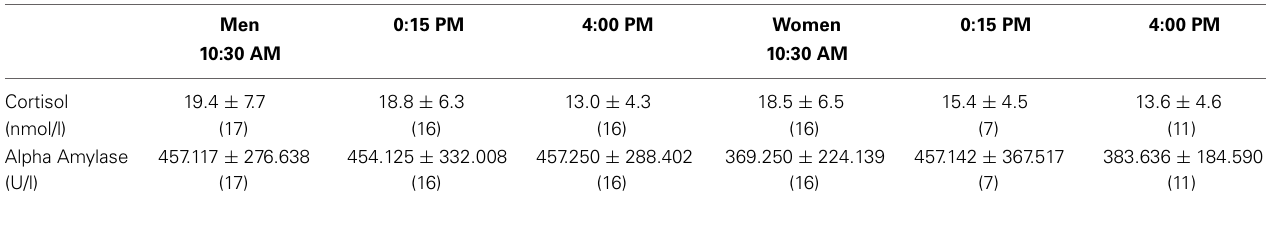
Table 1A | Salivary cortisol and alpha-amylase levels (mean ± SD ) before the CGT in men and women at different time-points during the day; number of subjects is indicated between brackets.